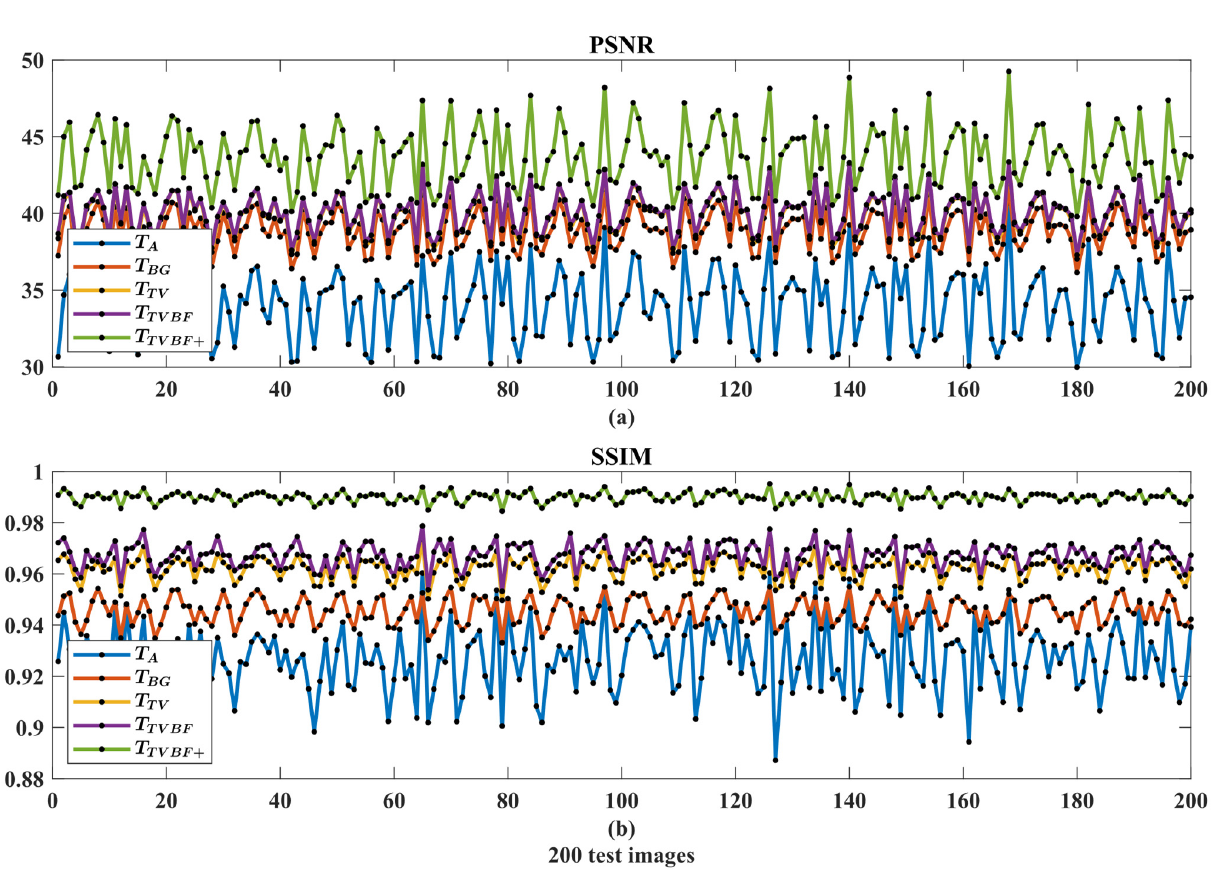
Figure 10. The evaluation indices of the 200 images. ( a ) PSNR; ( b )